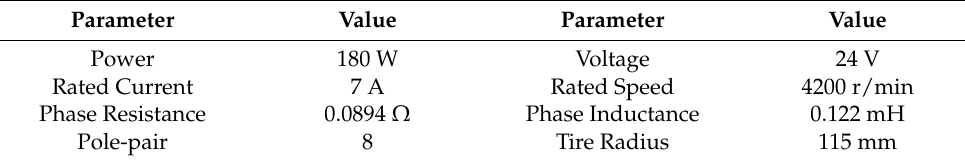
Table 2. Specifications of the traction BLAC motor.